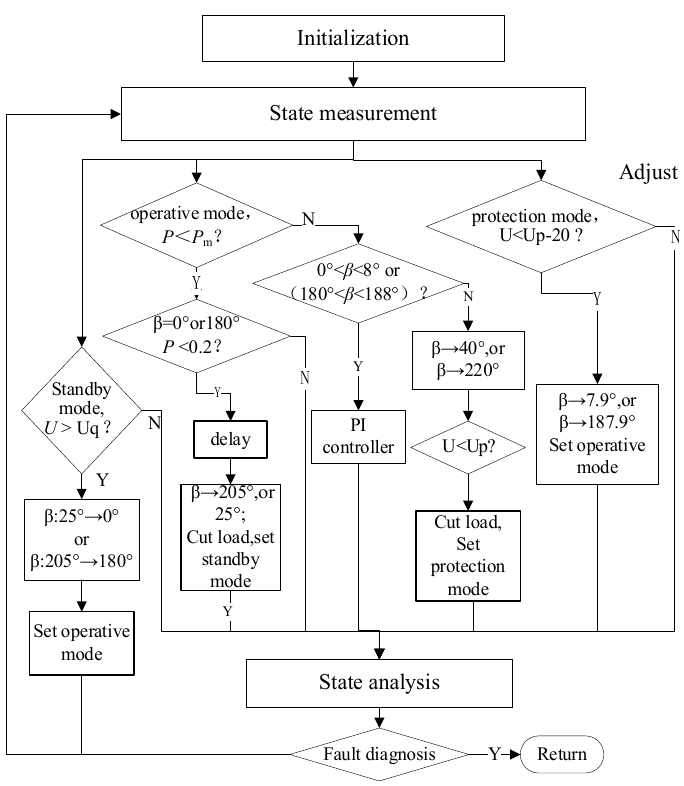
Figure 13. Control flow